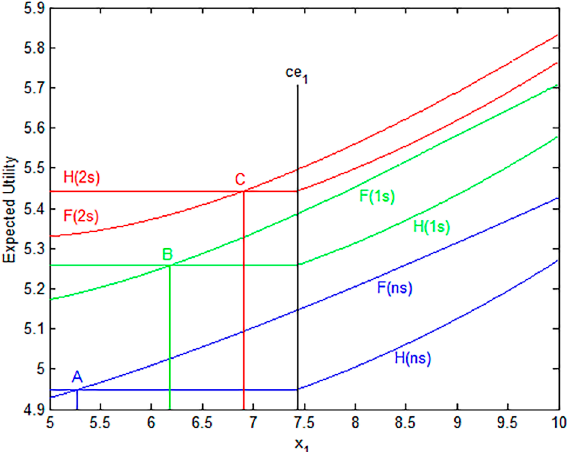
Figure 7. Evolution of thresholds for a risk-averse DM given uniform beliefs and signals on X